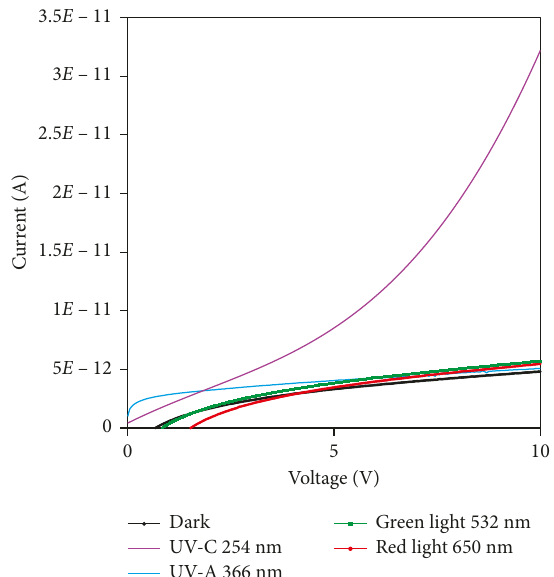
Figure 9: I-V characteristics of Ga different